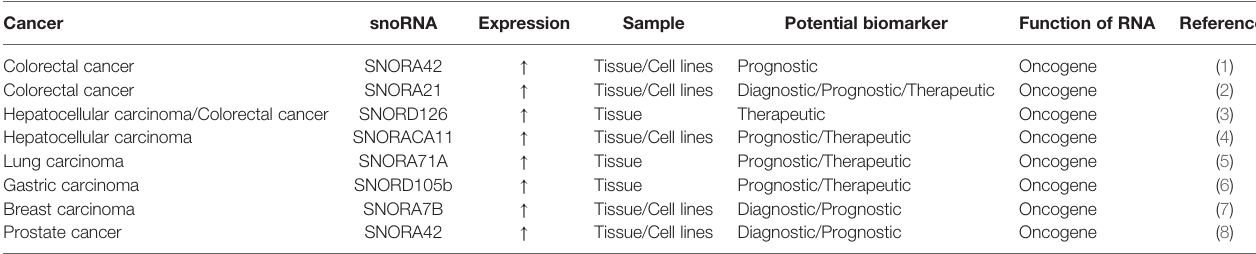
TABLE 4 | snoRNA as potential biomarker for colorectal cancer.